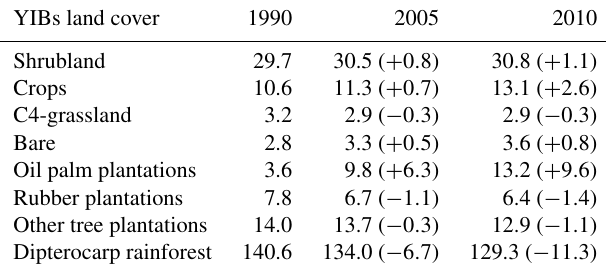
Table 2. Areal extents (Mha) of eight YIBs land cover types in maritime Southeast Asia. Extents encompass only the 57 grid cells that apply the land cover distributions derived from the Gunarso et al. (2013) analysis. The changes in areal extent (in Mha) relative to 1990 are listed in parentheses for 2005 and